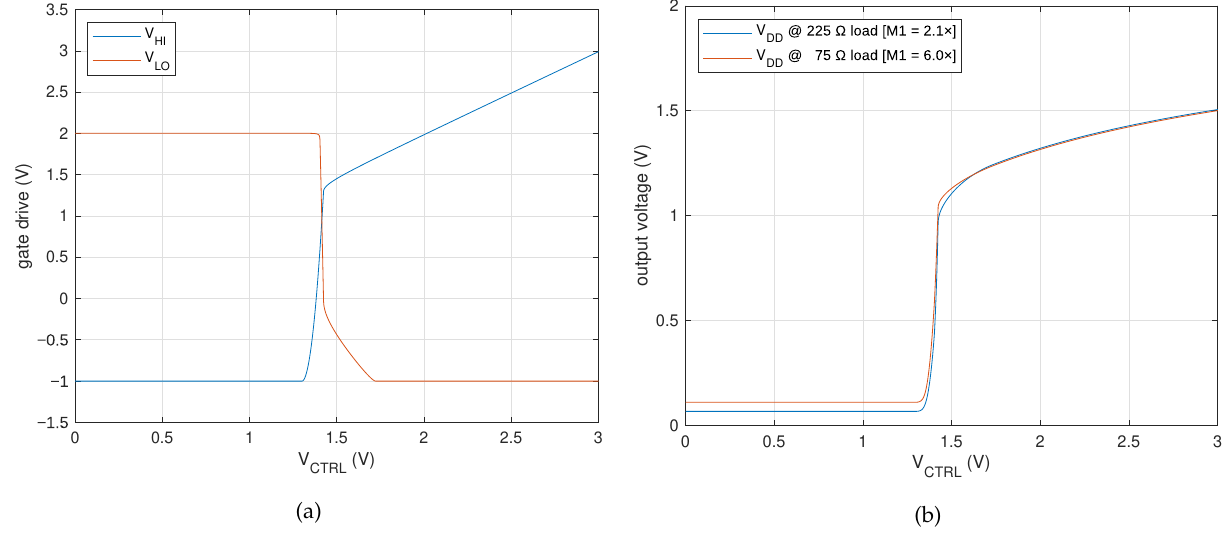
Figure 4. Simulations of the ( a ) driver circuit and ( b ) switch output voltage, performed using a Verilog-A implementation of the MoS 2 empirical model described in this work, and a commonly available Vishay Siliconix Si1013CX p-type MOSFET for the driver circuit, for two different loads corresponding to the two currents drawn by the two RF